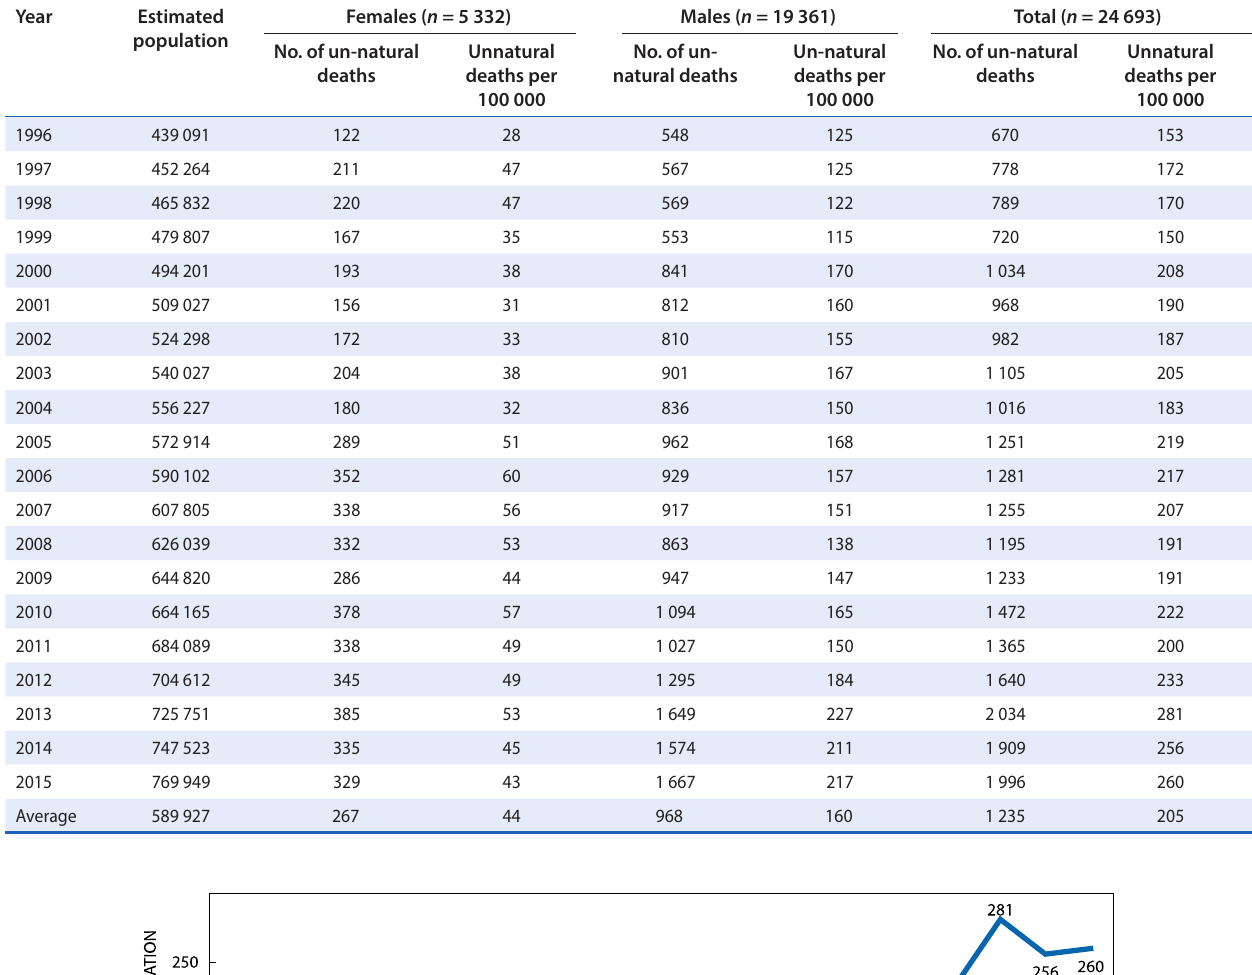
Table 1: Estimated unnatural deaths in the Mthatha area of South Africa by gender (1996–2015)